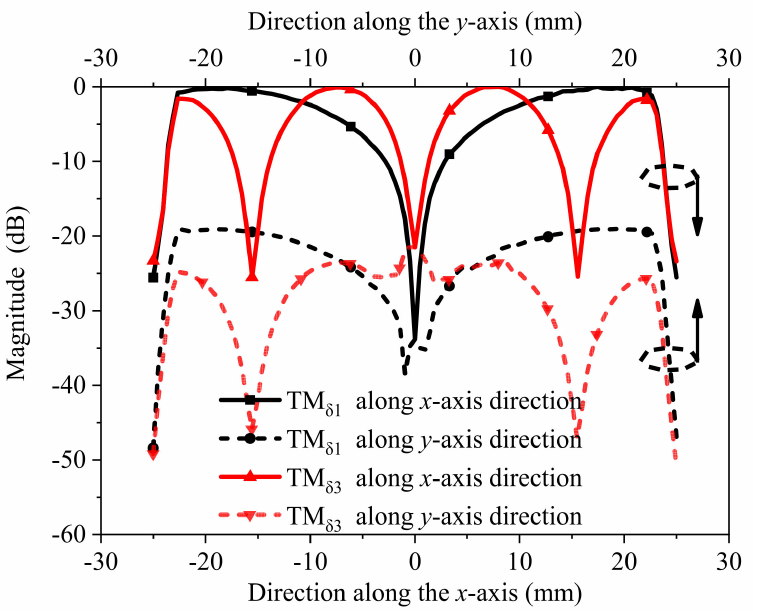
Figure 3. The magnitude of the electric fields distributed by the TM δ 1 and TM δ 3 modes along the x -axis and along the y